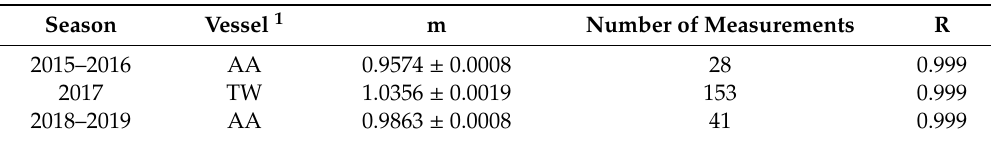
Table 1. Results of linear regressions (y = m × x) to clear-sky global modelled (x) and observed (y) SW irradiance. The Pearson linear correlation coe ffi cient, R, is also